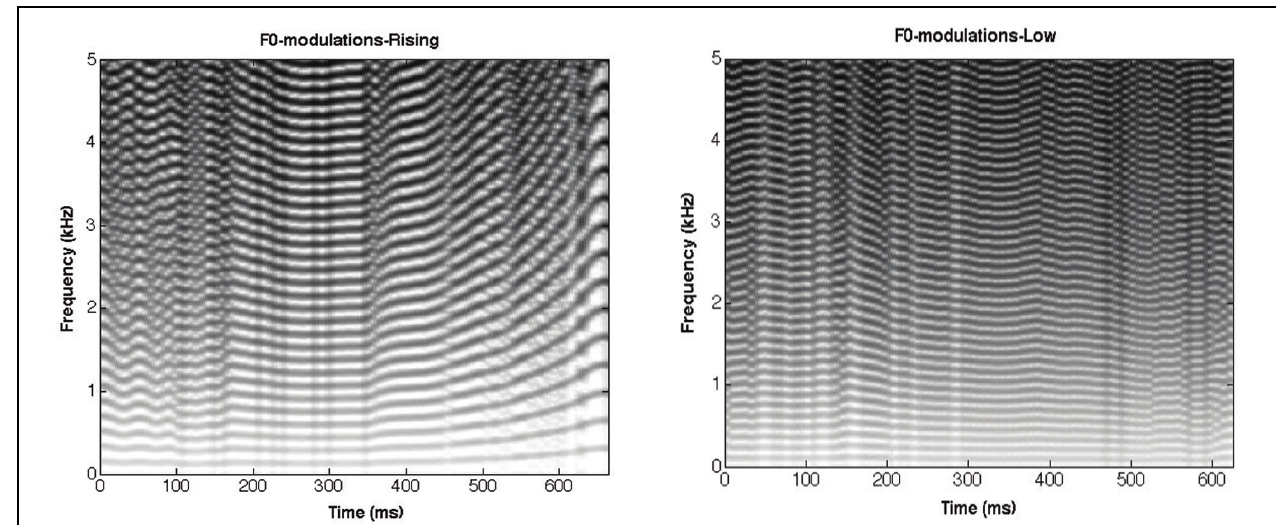
FIGURE 5 | Spectrograms of /ba/ low (left) and /ba/ rising (right) stimuli in the F0-modulation condition.